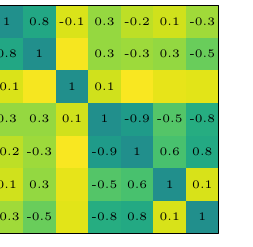
and (cid:27) are shown in orange FB tt